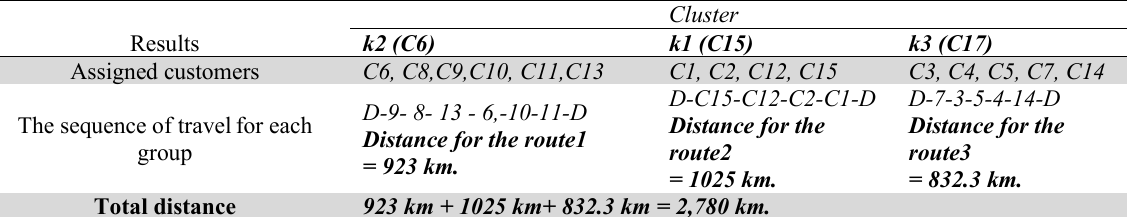
The results of the TSP model for this case